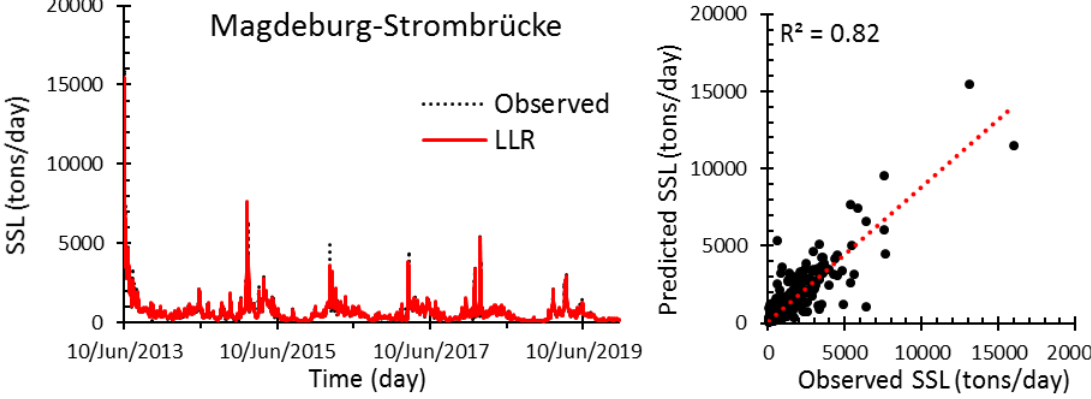
Figure 11. Observed and predicted SSL for the best LLR model for the Magdeburg-Strombrücke station in a testing phase.